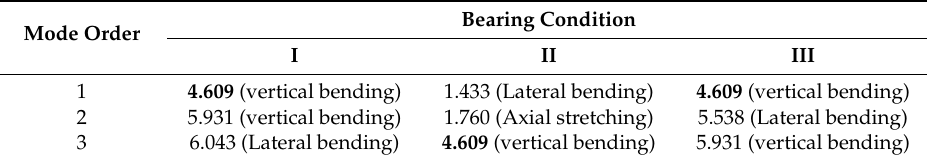
Table 5. Modal frequencies and mode shapes under different bearing conditions